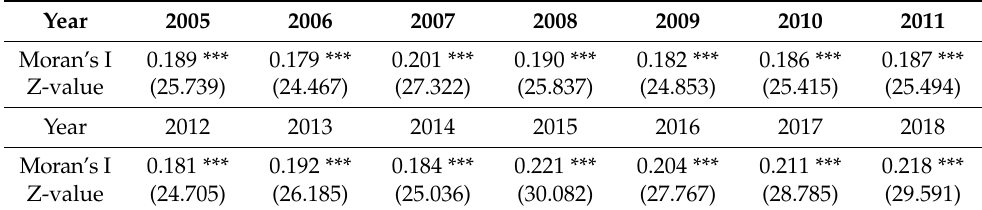
Table 10. Moran’s I test results of haze pollution in Chinese cities (2005–2018).